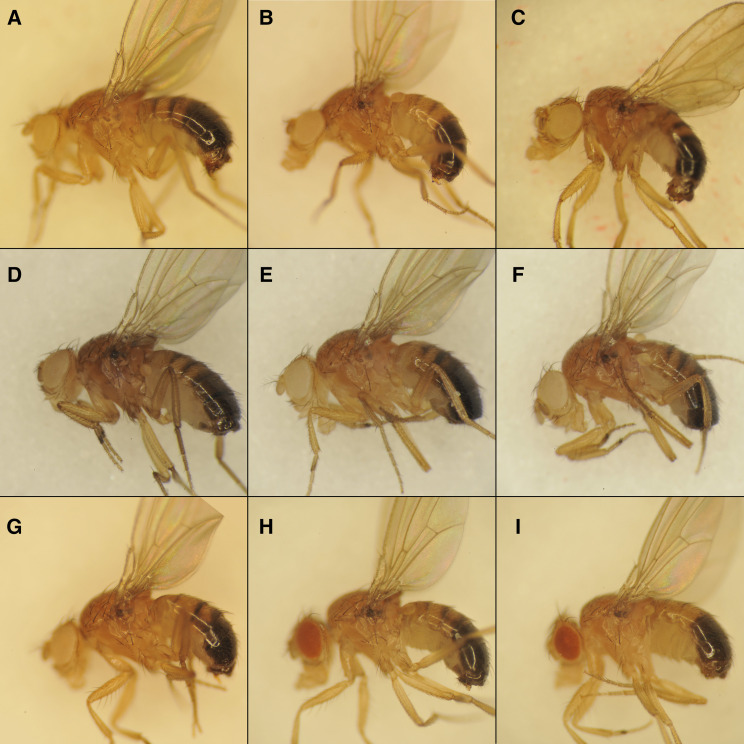
Mutations in the AANAT1 gene cause the speck phenotype of ectopic pigmentation in the wing hinge and darker body color. Adult males are shown with anterior to the left and dorsal up. A.) A w1118 male shows the wild type pigmentation at the ventral wing hinge region. B.) The speck1 allele (cn1
bw1 speck1) shows a “speck” of pigmentation at the ventral wing hinge. C.) The speck2/Df genotype (Df(2R)BSC356/SM6a) shows the dark speck at the wing hinge and a slightly darker body color. D.) An insertion allele of AANAT1 (Mi{ET1}AANAT1MB02738) shows a darker body color and a pronounced wing hinge spot. E.) Mobilization of the insertion in D can revert the speck phenotype (speckT1) F.) An imprecise excision of the insertion in D that removes an AANAT1 transcriptional start site produces a speck phenotype (speckG1). G.) A CRISPR allele (speck47B) that deletes 1218 bp shows an intermediate speck phenotype. H. and I.) Knock-down of the AANAT1 gene by two different GAL4 drivers and two different hairpin locations produce a speck phenotype (H: Tubulin-GAL4, UAS-dicer2; UAS-AANAT1HMS01617 and I: apterous-GAL4; UAS-AANAT1JF02142).